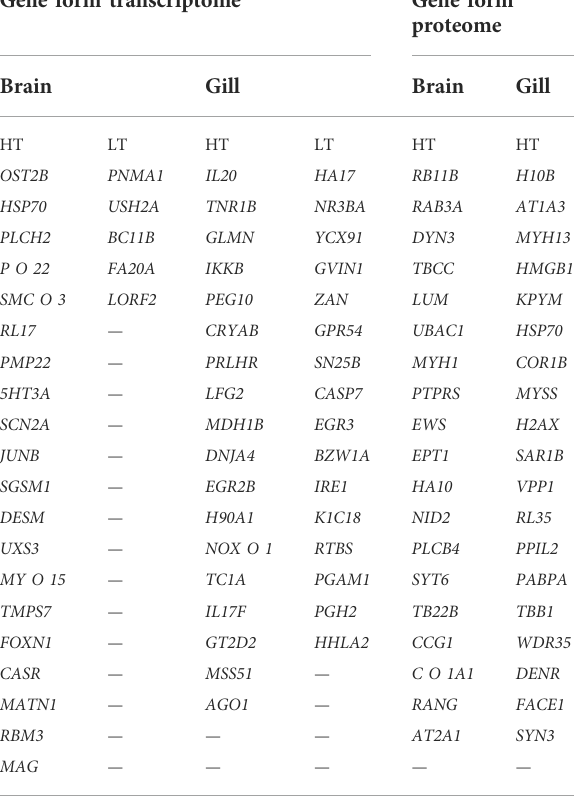
TABLE 3 The genes that may be highly related to temperature